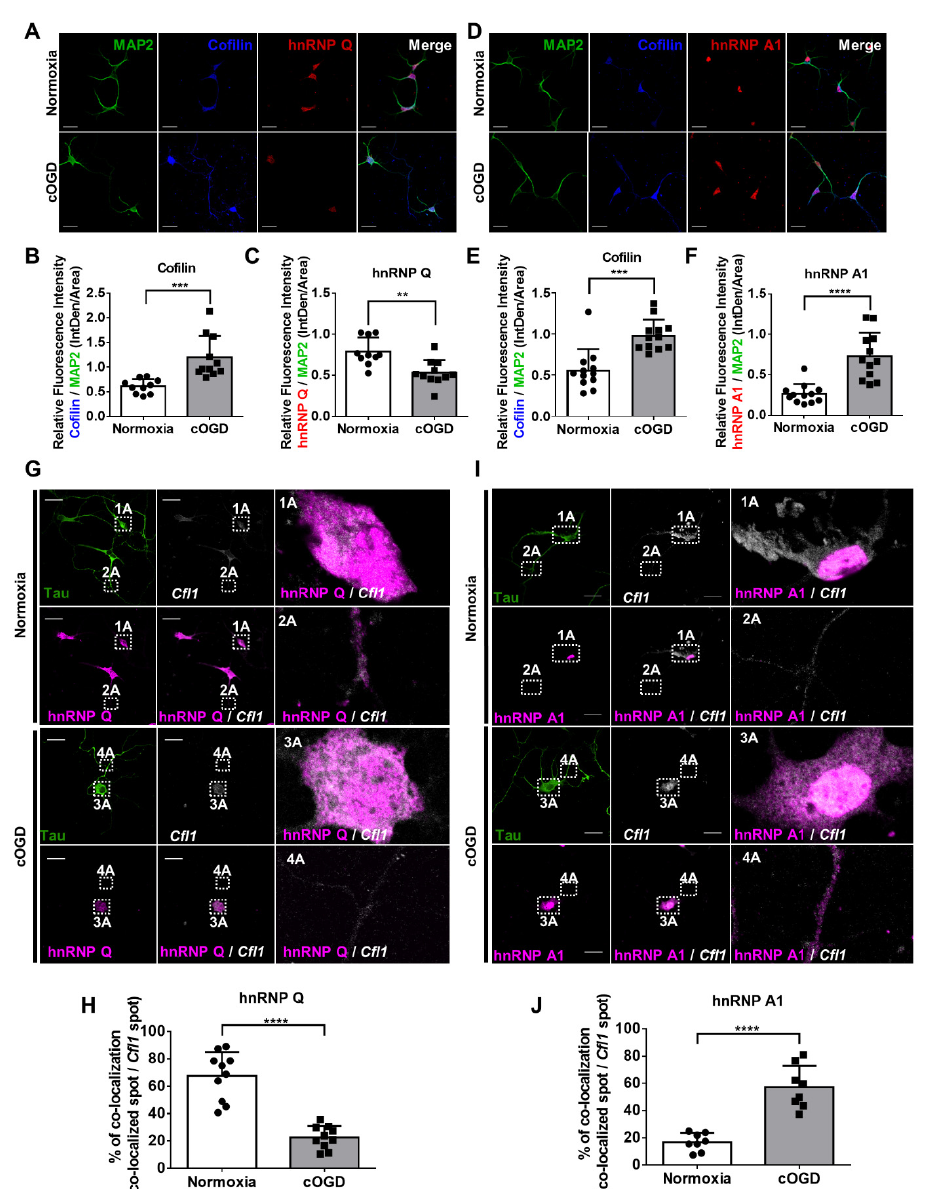
Figure 6. HnRNP Q and hnRNP A1 re-localizes under cOGD conditions, which increases the interaction between hnRNP A1 and Cfl1 mRNA. ( A ) The immunofluorescence labeling of cofilin (blue), hnRNP Q (red), and MAP2 (green) in primary hippocampal neuron that was cultured under normoxia conditions (top) and cOGD conditions (bottom). Scale bar = 30 µ M. ( B , C ) Quantification of relative fluorescence intensity of cofilin ( B ) and hnRNP Q ( C ) in normal hippocampal neuron (white) or cOGD neuron (gray), normalized to the intensity of MAP2 ( n = 11). ( D ) The immunofluorescence labeling of cofilin (blue), hnRNP A1 (red), and MAP2 (green) in primary hippocampal neuron that was cultured under normoxia conditions (top) and cOGD conditions (bottom). Scale bar = 30 µ M. ( E , F ) Quantification of relative fluorescence intensity of cofilin ( E ) and hnRNP A1 ( F ) in normal hippocampal neuron (white) and cOGD neuron (gray), normalized to the intensity of MAP2 ( n = 12). ( G ) The co-localization between Cfl1 mRNA and hnRNP Q in primary hippocampal neuron that was cultured under normoxia conditions (top) and cOGD conditions (bottom) was observed by the immunofluorescence labeling of hnRNP Q (magenta) and Tau (green), along with the RNA FISH of Cfl1 mRNA (white) using Stellaris™ RNA FISH. The co-localization of hnRNP Q and Cfl1 mRNA in soma (1A and 3A) and axon (2A and 4A) of the neuron is shown through scaled-up images. Scale bar = 30 µ M. ( H ) Quantification of co-localization between Cfl1 mRNA and hnRNP Q in normal neuron (white) and cOGD neuron (gray) from experiments in ( G ), measured by the percentage of co-localization (co-localized Cfl1 mRNA spot/total Cfl1 mRNA spot) ( n = 10). ( I ) The co-localization between Cfl1 mRNA and hnRNP A1 in primary